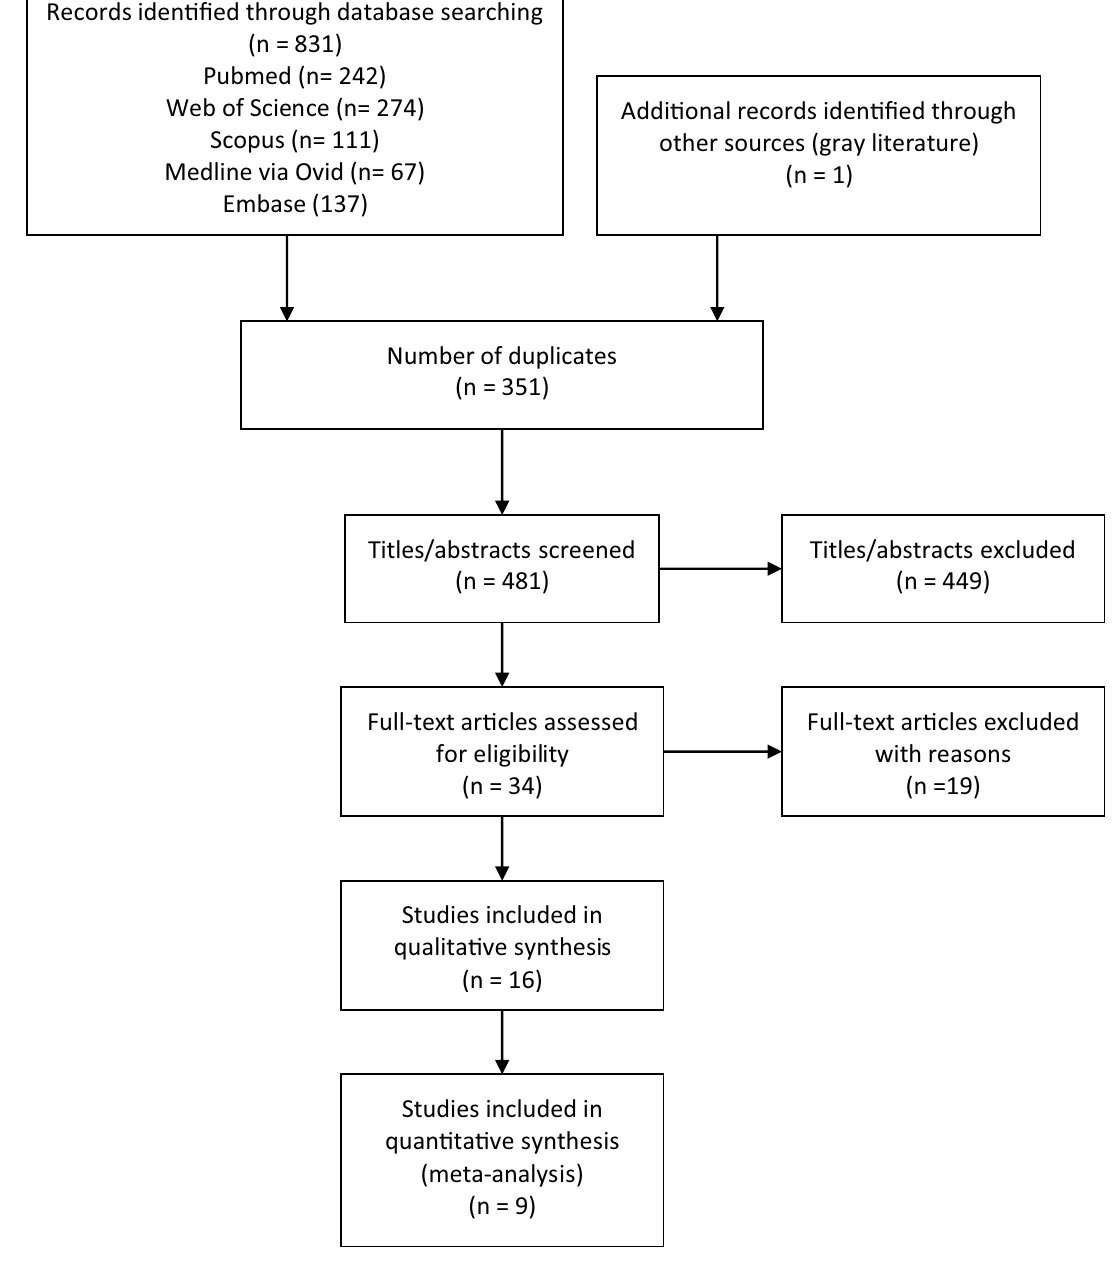
Figure 1. Flow chart depicting the search